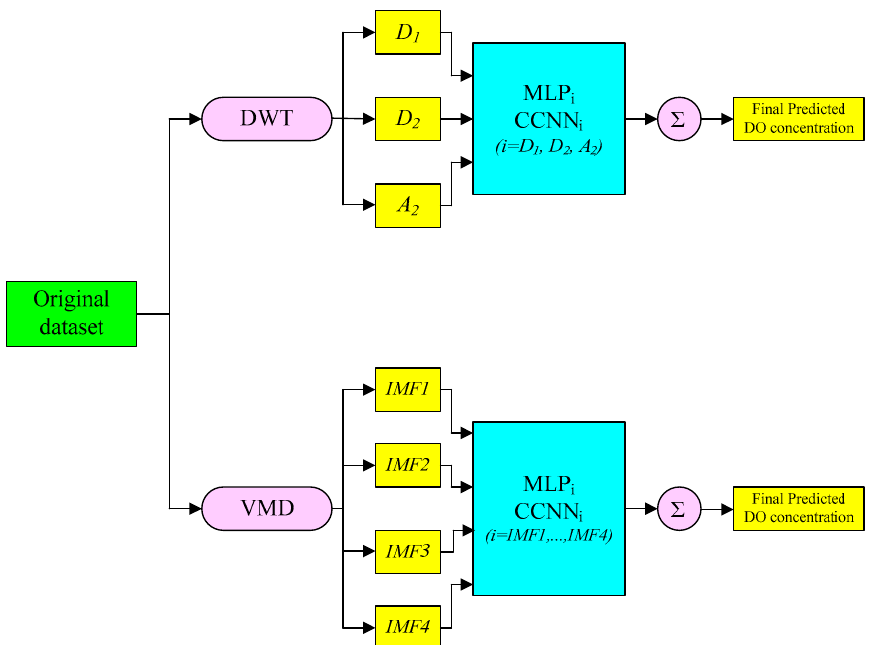
Figure 4. Flowchart for DWT- and VMD-based soft computing modeling.